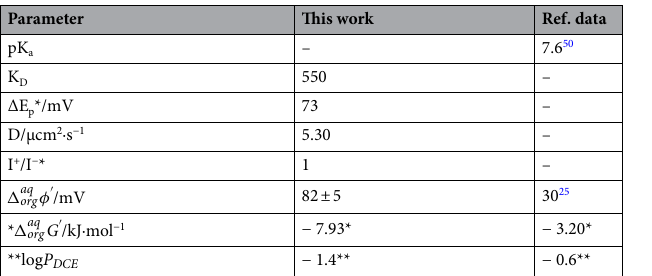
Table 1. Summarized heroin physicochemical parameters. * (cid:31) orgaq G ′ = − z · F · (cid:31) orgaq (cid:30) the charge and the Faraday constant, respectively. ** log P constant and T is the temperature (288.15 K).